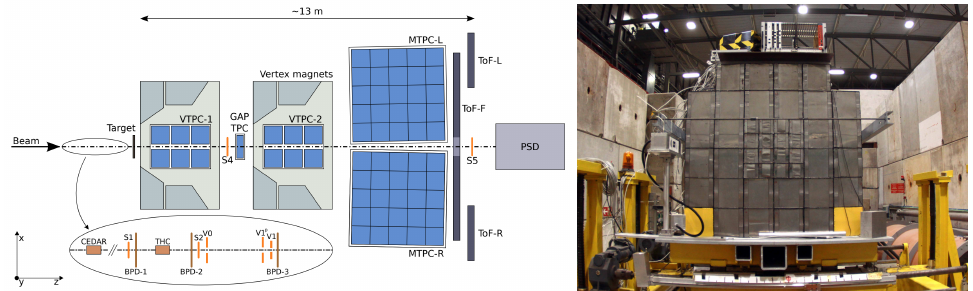
Figure 1. A scheme of the NA61/SHINE experiment [10] and a front view photo of the Projectile Hadronic Calorimeter. PSD is used for triggering, centrality and event plane determination.